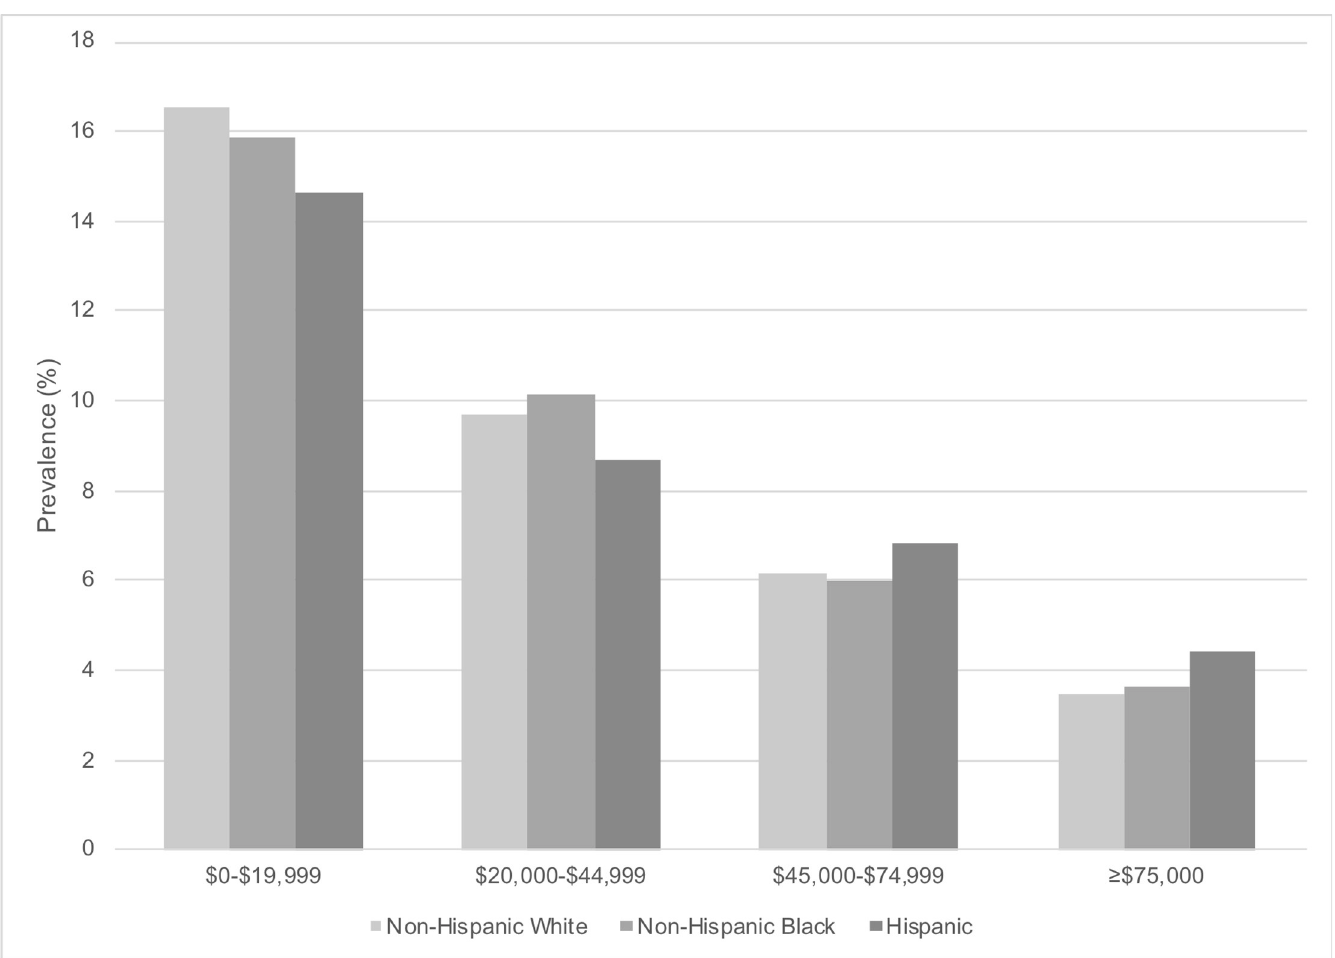
Fig 1. Weighted prevalence of probable depression by race/ethnicity and household income in U.S. adults (N = 26,382). The National Health and Nutrition Examination Survey (NHANES) 2007–2016. Missing values for household income (n = 1,935). Weighted to the U.S. population. Probable depression defined by Patient Health Questionnaire-9 (PHQ-9) cutoff of �